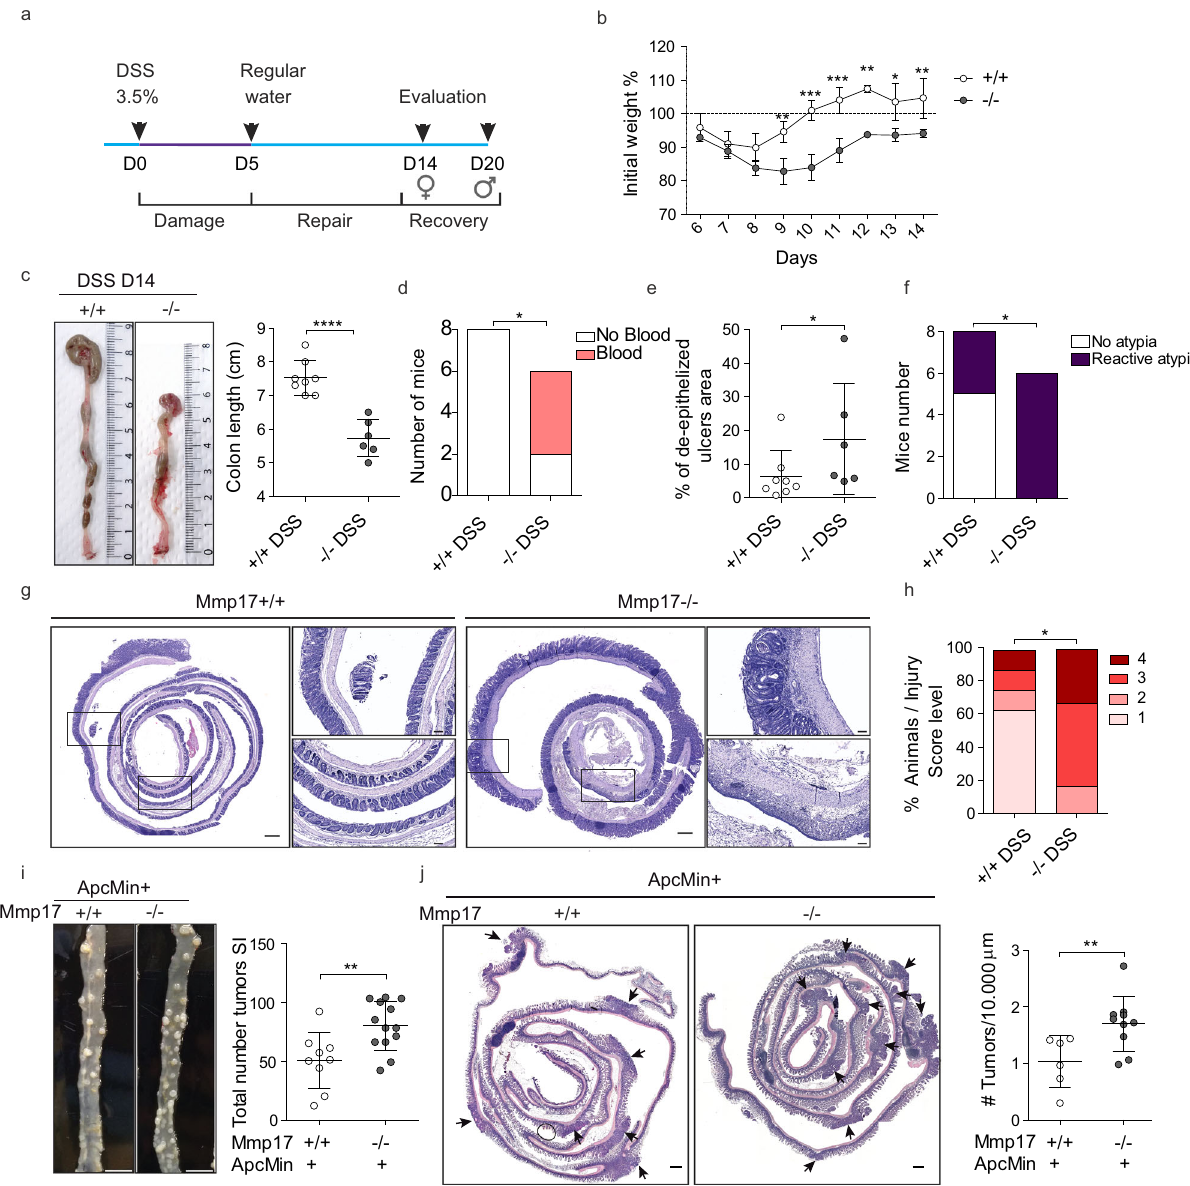
Fig. 6 MMP17 absence hinders long-term repair in mouse intestinal epithelia and leads to increased tumorigenesis. a Timeline of DSS-long treatment. Mice were exposed to 3.5% DSS for 5 days followed by 14 (females) or 19 days (males) days of regular water to allow epithelial restoration. b Weight loss relative to % to initial weight. n = 3 KO and 4 WT mice per genotype. Represented one experiment with females. c Representative images showing colon length at end point and its quanti fi cation. d Graph shows the presence of blood in stool/colon lumen at end point. e Graph represents the percentage of unhealed areas (ulcers) in WT and KO colonic mucosa at end point. f Graph shows the incidence of reactive atypia (or reactive epithelial changes after DSS). g Representative H&E pictures of colon swiss rolls showing healed crypts in WT vs ulcered areas and reactive atypia in KO. Scale 500 µ m. h Injury score representation of damaged colon evaluation. n = 6 KO and 8 WT mice per genotype in ( c – h ). i Representative pictures showing tumor incidence in a portion of the small